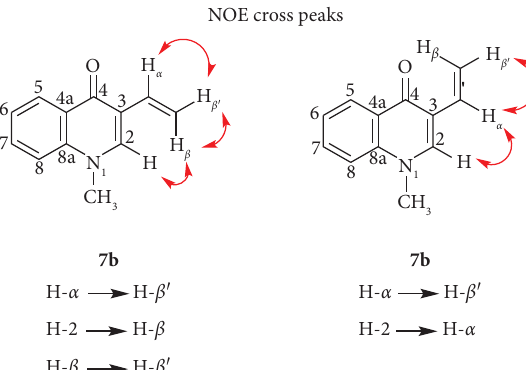
Figure 3: Main NOE cross peaks observed in the NOESY spectrum of compound 7b and diferent conformations of the vinyl